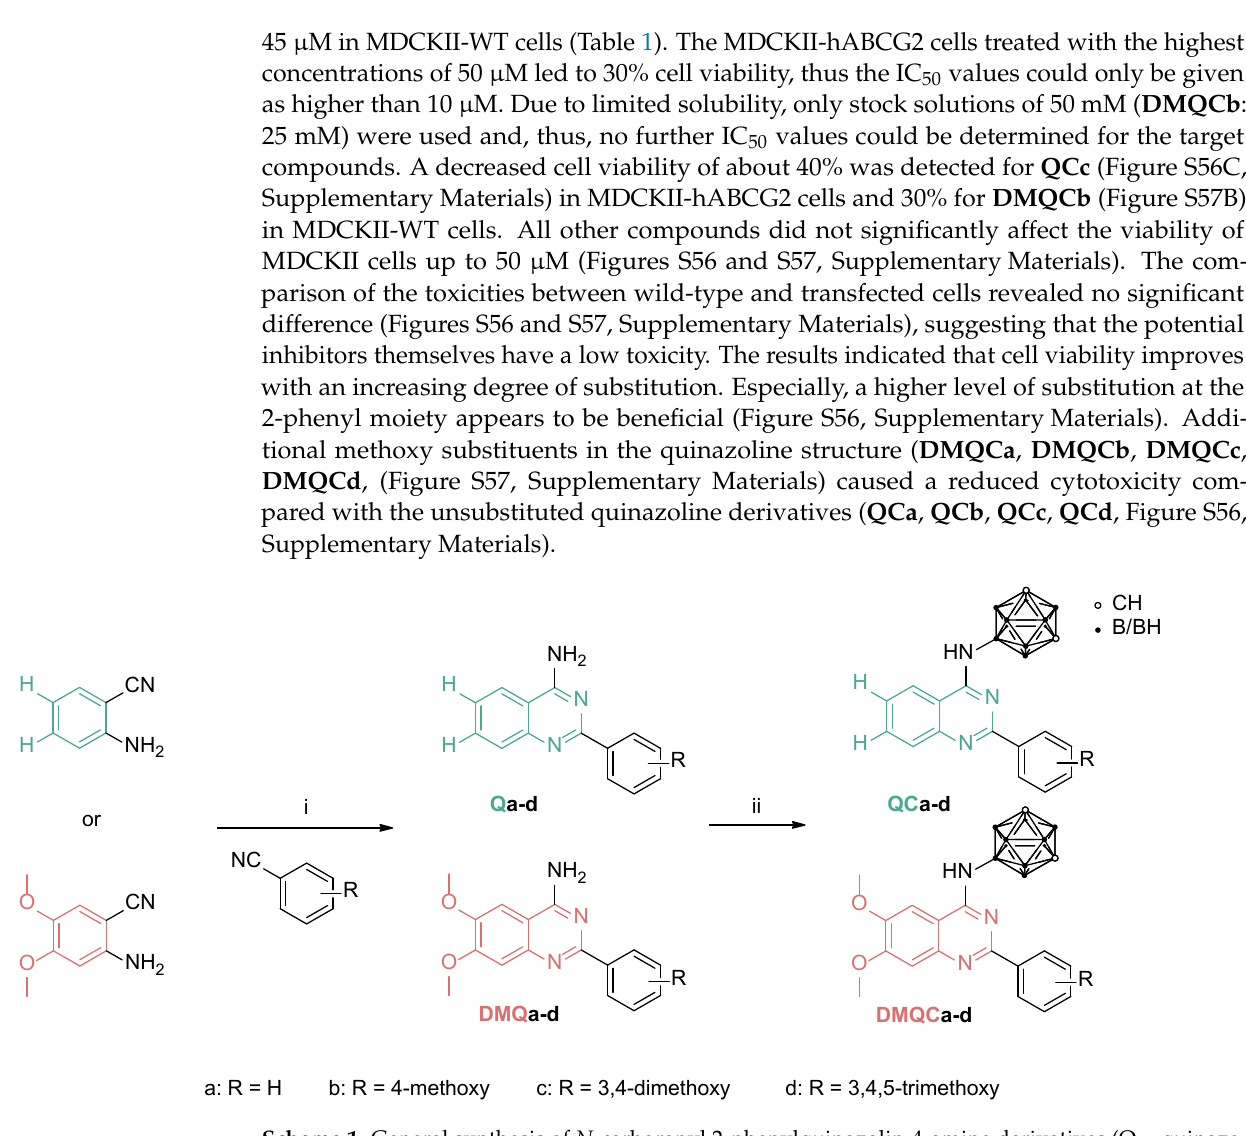
Scheme 1. General synthesis of N -carboranyl 2-phenylquinazolin-4-amine derivatives (Q = quinazo- line scaffold, green; DMQ = 6,7-dimethoxyquinazoline, red). Reagents and conditions: (i) (1) NaH, THF, reflux, 15−24 h; (2) HCl/H 2 O (ii) closo -9-Br-1,7-dicarbadodecaborane ( CbBr ), SPhos Pd G4, SPhos, KO t Bu, 1,4- dioxane, 80 °C, 1−2 h.